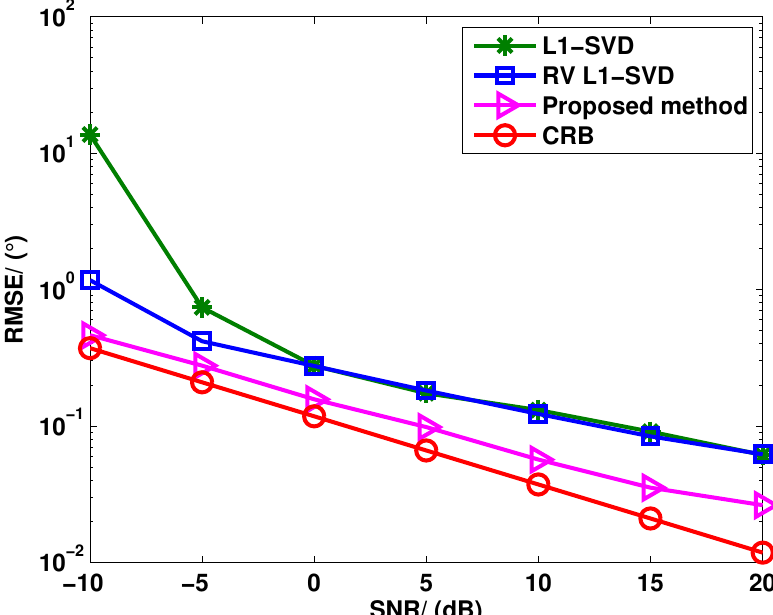
Figure 2. RMSE of l -SVD, RV l -SVD and the proposed method for uncorrelated targets 1 1 when the SNR varies from − 10 dB to 20 dB.